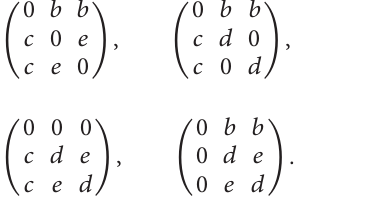
Figure 2: Allowed 𝑚 2,3 versus 𝑚 1 (left), 𝛼 𝑀